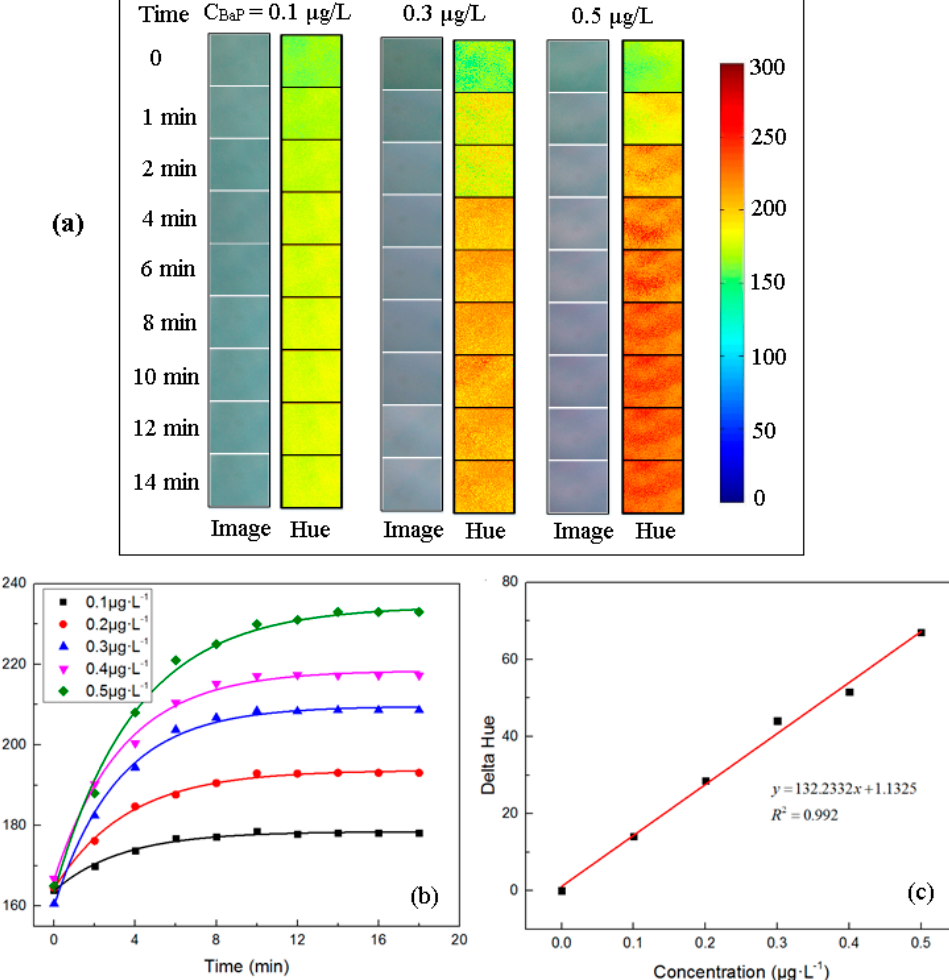
Figure 2. ( a ) SPR color images and corresponding 2D hue profiles recorded at different immunoreaction times with different concentrations of aqueous BaP solutions, ( b ) average hue of SPR images versus the immunoreaction time of BaP at different concentrations, ( c ) Average hue variation as a function of BaP